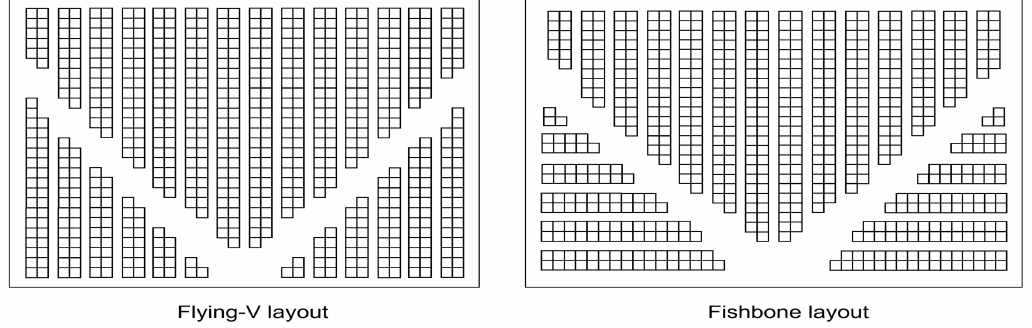
Figure 2. The flying-V ( left ) and fishbone layout ( right